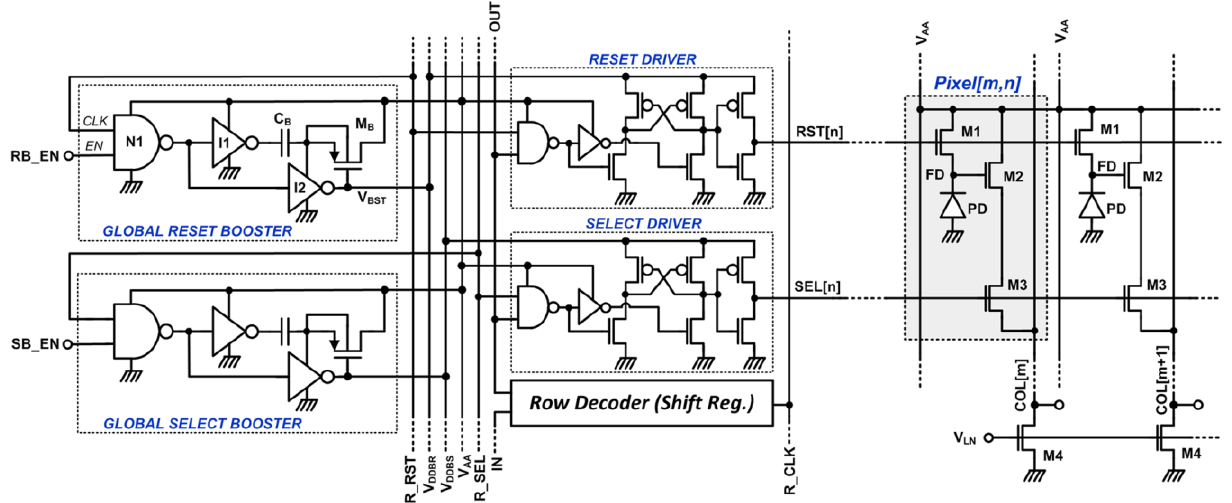
Figure 4. Global, row, and pixel level circuits for reset and select boosting in three-transistor (3T) CMOS APS